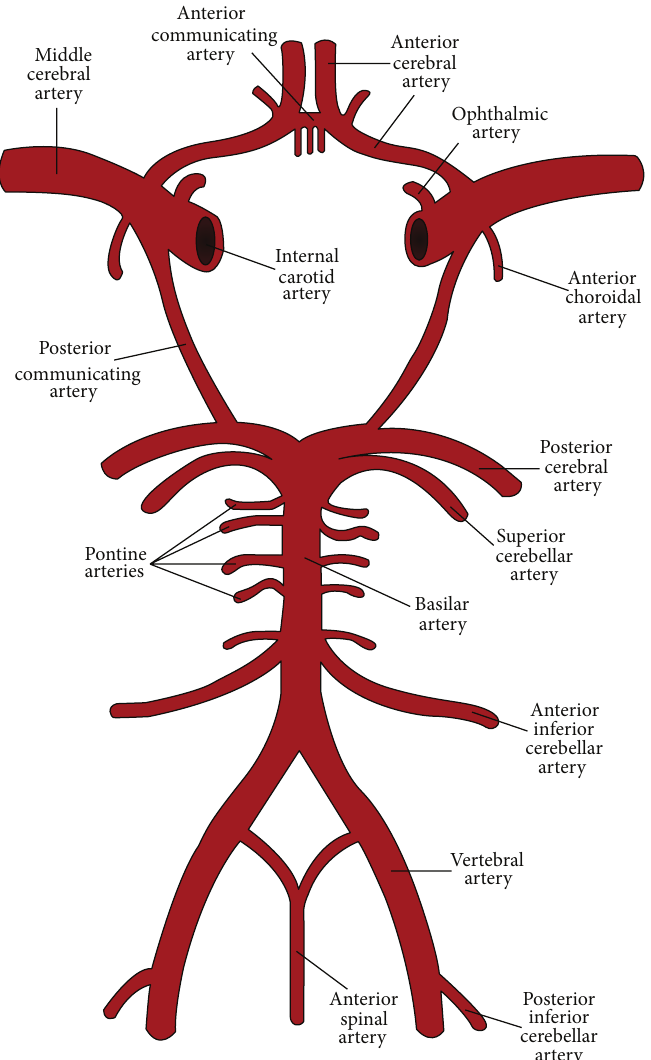
Figure 1: Vertebral-basilar arteries and circle of